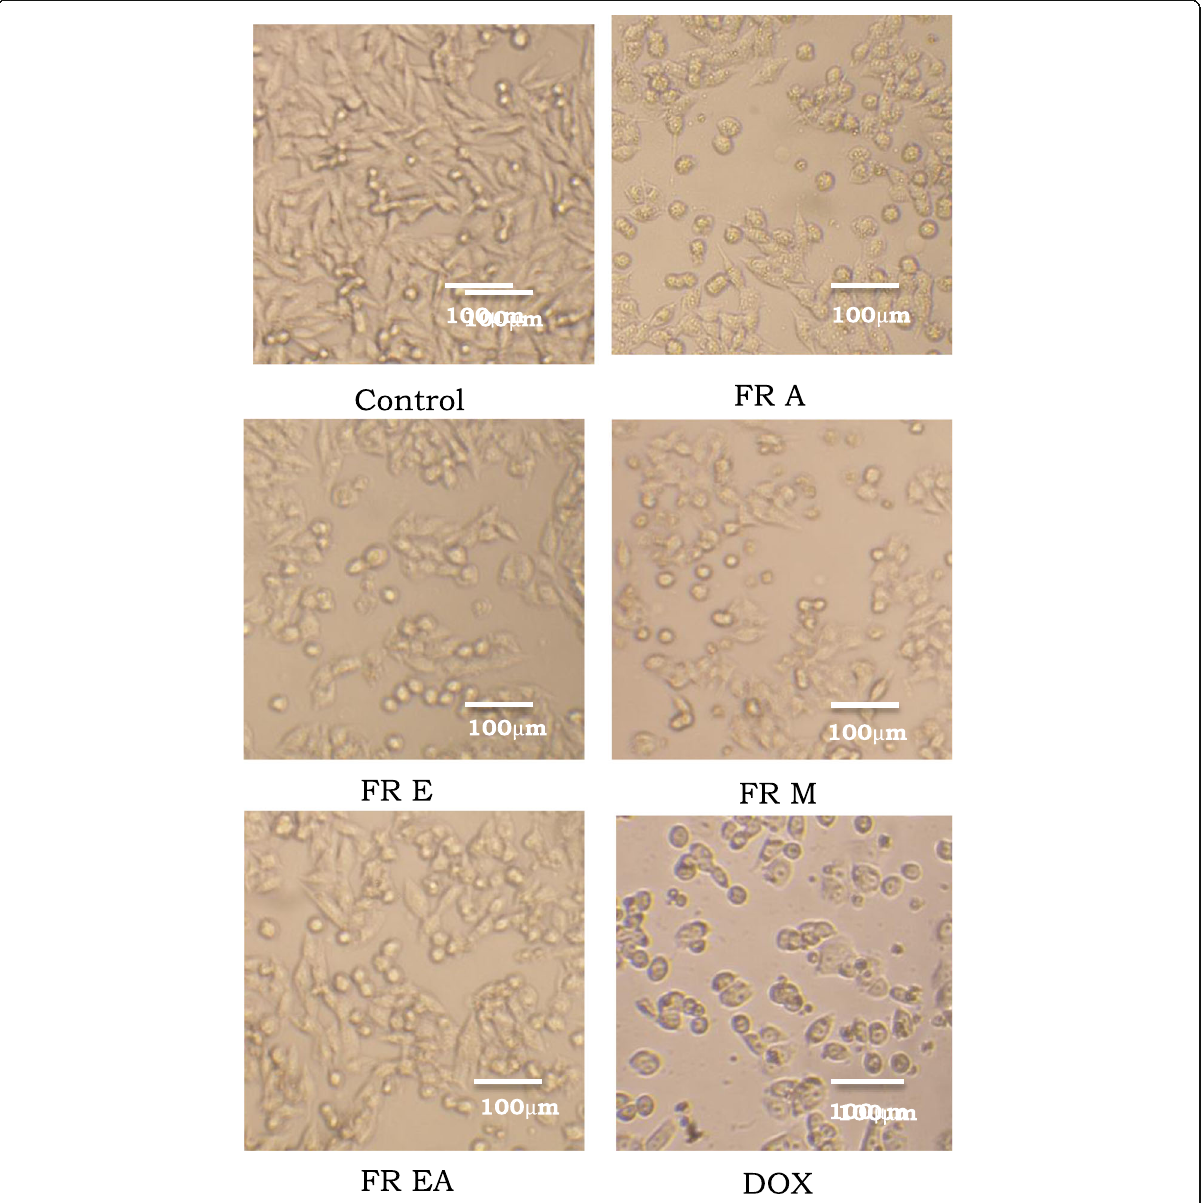
Fig. 2 Morphological changes observed in IMR 32 cell line when treated with IC 50 concentrations of F. religiosa latex solvent extracts along with control (IMR 32) and doxorubicin (DOX)-treated cells. A — acetone (102.84 μ g/ml); E — ethanol (4.8 μ g/ml); M — methanol (146.01 μ g/ml); EA — ethyl acetate (39.24 μ